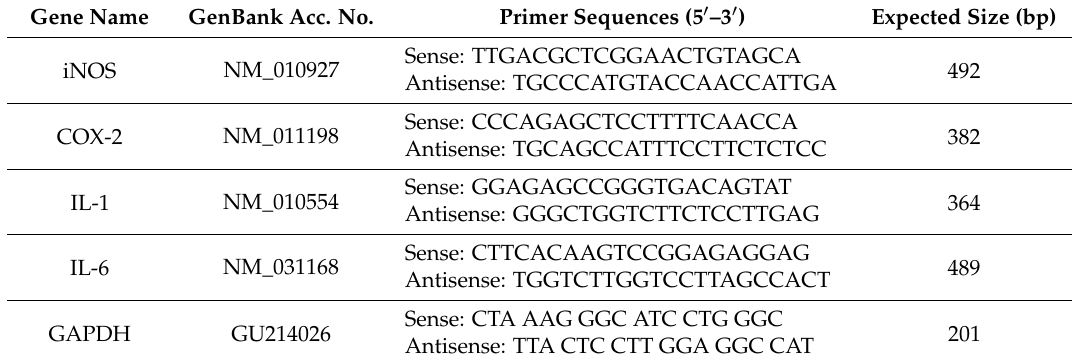
Table 2. Primer sequences used for